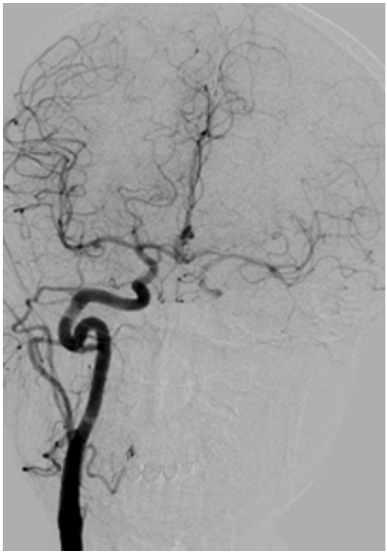
Figure 3. Anteroposterior right carotid angiogram showing con- tralateral supply of the left anterior cerebral artery (ACA) and medial cerebral artery (MCA). There is not supply of the CCF from the right